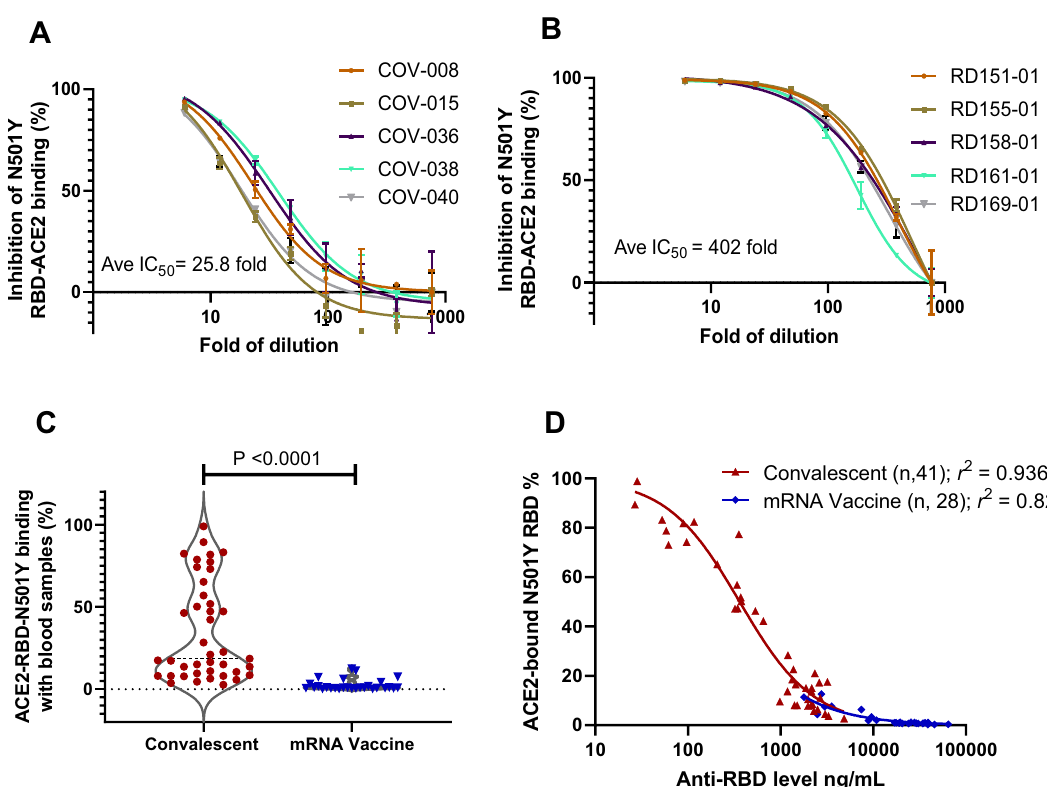
Figure 4. mRNA vaccine far more effective than natural immunity in neutralizing N501Y RBD mutant in ACE2 binding. ( A ) Dilution study to determine the IC 50 of representative convalescent samples with median levels of anti-RBD antibodies. ( B ) Dilution study to determine the IC 50 of representative vaccinated samples with median levels of anti-RBD antibodies. ( C ) Vaccinated blood samples more effective than convalescent ones to inhibit N501Y RBD in ACE2 binding ( P < 0.0001). ( D ) Antibody concentration-dependent inhibition of N501Y RBD and ACE2 binding with blood samples from natural immunity ( r 2 = 0.926) and mRNA vaccination ( r 2 =